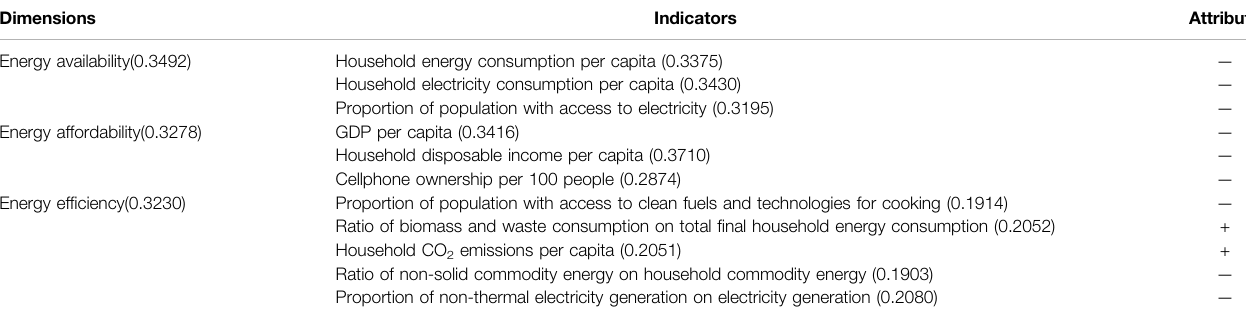
TABLE 1 | Indicators selected for each of the dimensions. Dimensions Indicators Attribute Energy availability(0.3492) Household energy consumption per capita (0.3375) Proportion of population with access to electricity (0.3195) Energy